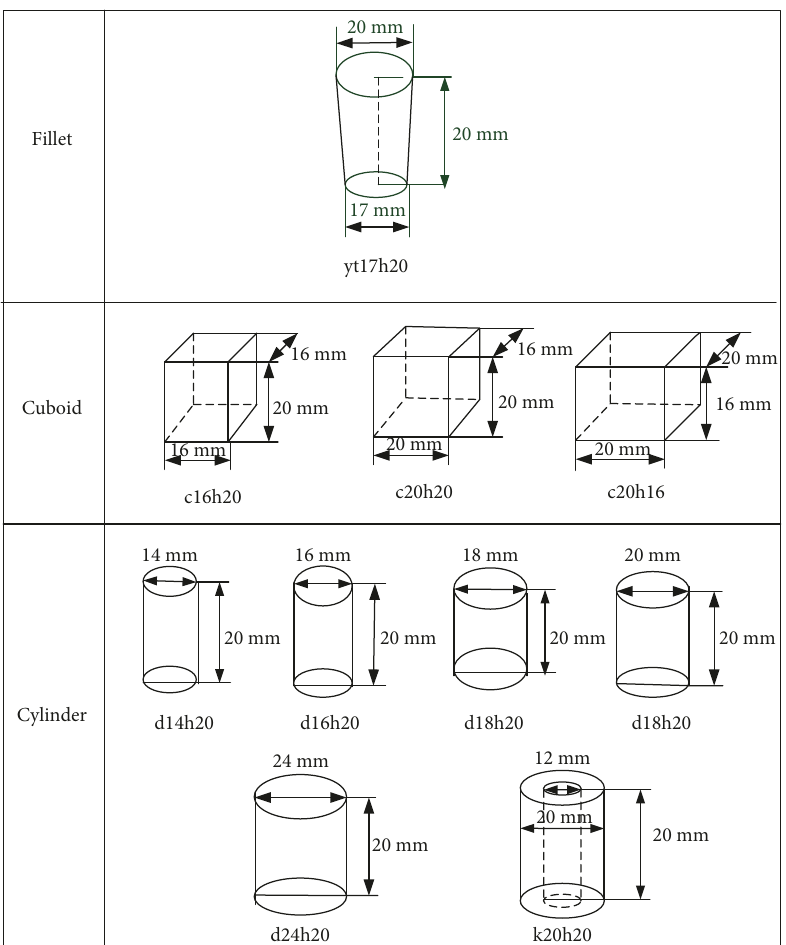
Figure 1: Shape and size diagram of